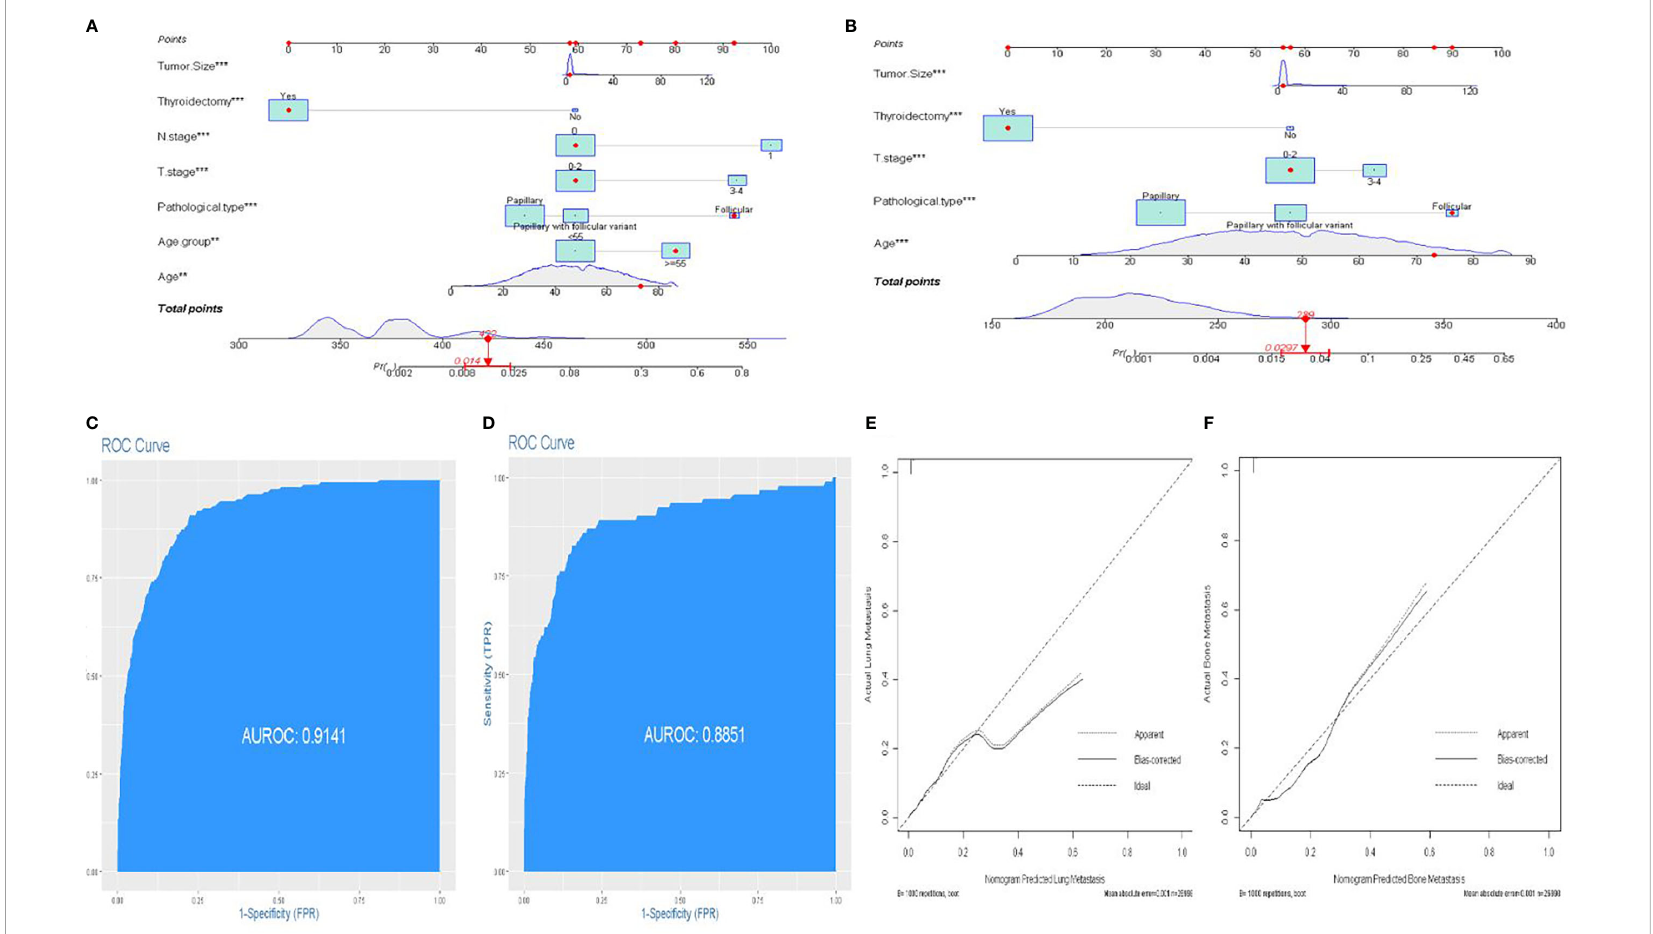
FIGURE 4 An individualized nomogram predicting bone metastasis and lung metastasis. (A) Nomogram predicting the probability of lung metastasis. (B) Nomogram predicting the probability of bone metastasis. (C) The ROC curve of the nomogram with lung metastasis. (D) The ROC curve of the nomogram with bone metastasis. (E, F) Calibration curves of the nomogram for the probability of lung metastasis and bone